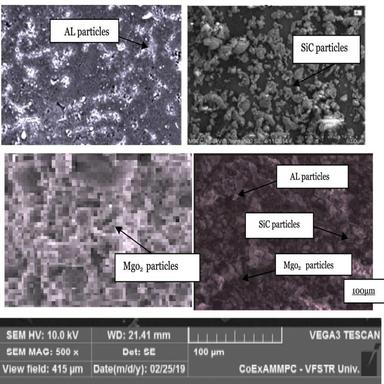
SEM images FGM reinforced with the following materials. (a) No reinforcements. (b) Al-Silicon carbide. (c) Al-Magnesium oxide. (d) Al-Silicon carbide-Magnesium oxide.